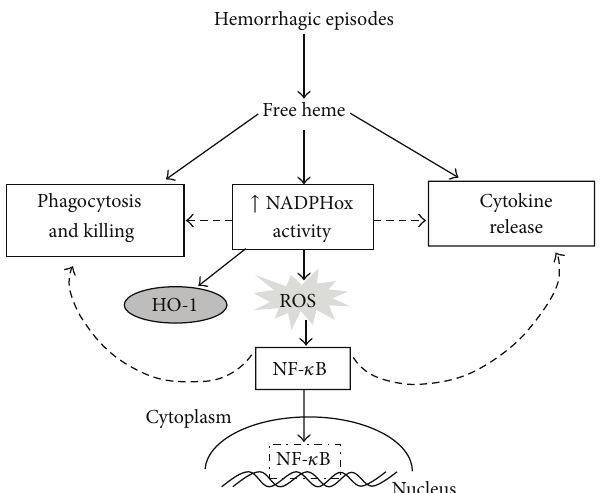
Figure 8: Heme induces a proinflammatory profile in AM. Heme induces NADPHox-dependent ROS production and NF- 𝜅 B nuclear translocation. These processes can be directly related to NO produc- tion, phagocytosis, killing, and cytokine release, functions that are involved in the inflammatory response induced by